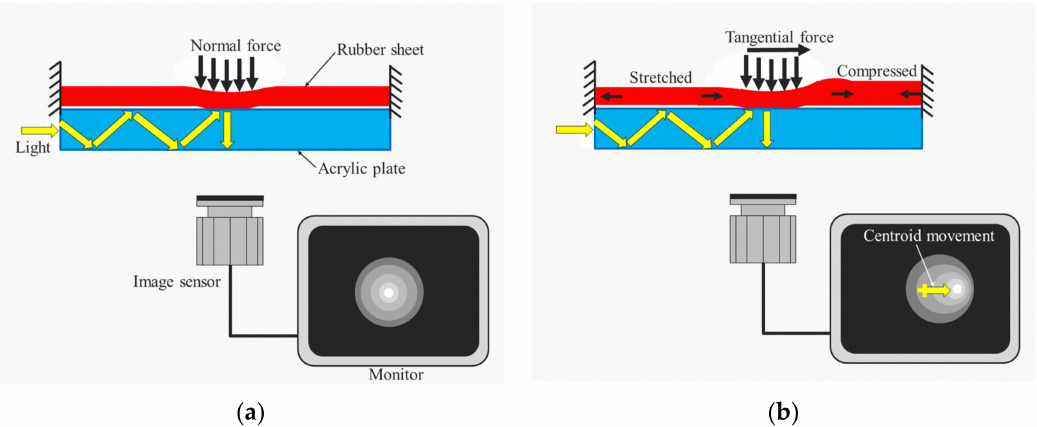
Figure 7. Sensing principle of fingertip-mounted tactile sensor: ( a ) For normal force sensing, since the contact area expands according to the applied normal force, the normal force value is calculated from the integrated grayscale value. ( b ) For tangential force sensing, since movement of the contact area increases with an increase in tangential force, the tangential force value is estimated from the contact area